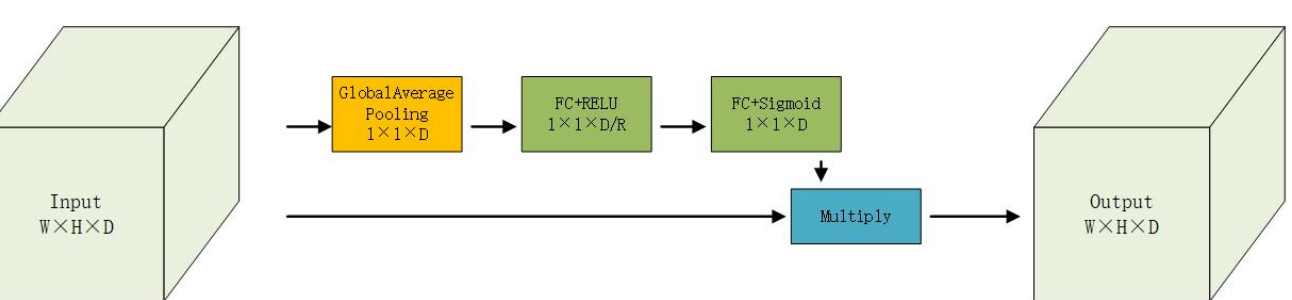
Figure 3. SE-net channel attention network model. FC replies to a fully connected